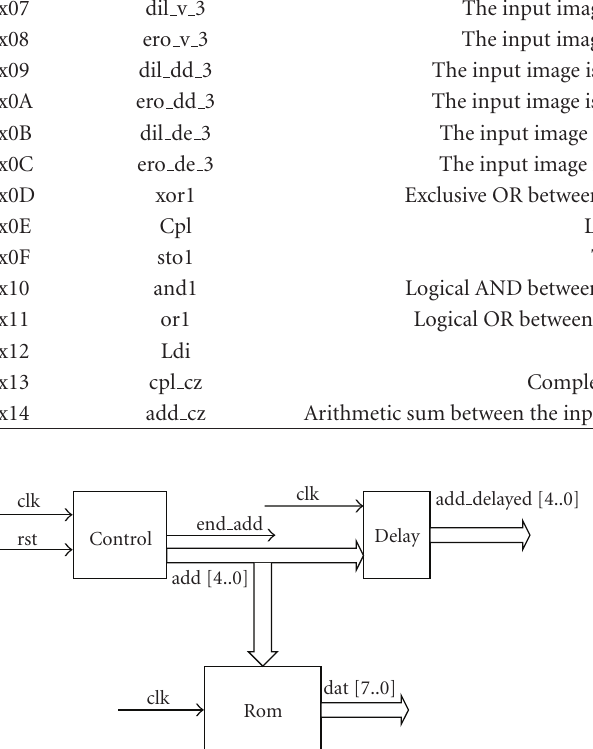
Figure 7: Simulation example of ROM